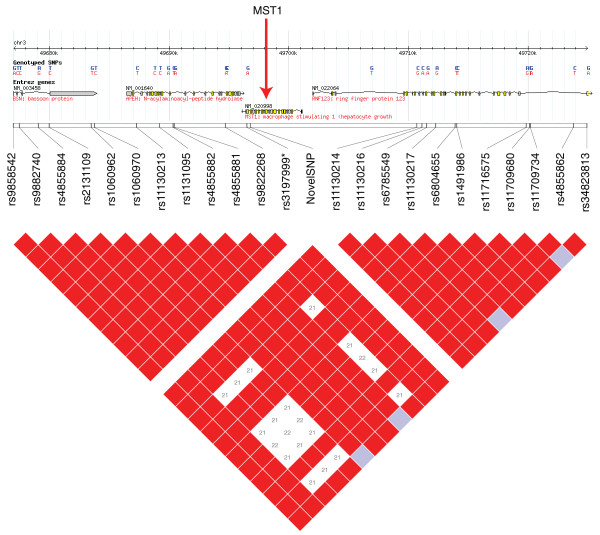
The linkage disequilibrium structure in the immediate region of the MST1 gene. Red boxes indicate SNPs in high LD. rs3197999, which has previously been associated with inflammatory bowel disease, and our novel nonsense SNP are highlighted in blue.